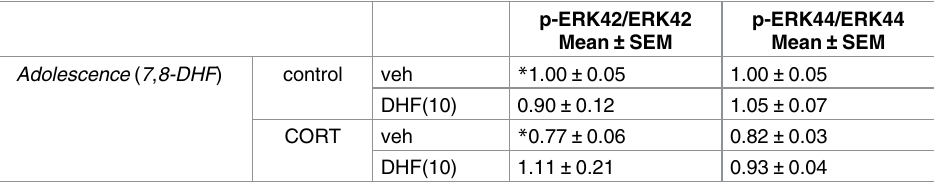
Table 4. Protein levels in the vHC of adult mice exposed to CORT during adolescence ± 7,8-DHF (10 mg/kg). 7,8-DHF influenced p-ERK42/ERK42 in CORT-exposed mice (CORT × 7,8-DHF interaction F (1,28) = 4.2, p = 0.05). Post hoc tests indicatedthat control + veh group significantlydiffered from CORT + veh group as reportedin independent experiments (see Table 3 and Fig 3) (indicatedby asterisks, * p < 0.05), but 7,8-DHF eliminatedthis difference. CORT decreased p-ERK44/ERK44, but there was no effect of 7,8-DHF (main effect CORT F (1,27) = 8.1, p = 0.008, no interaction).Valuesindicate fold changefrom control + veh group. Raw data for this table can be found in S1